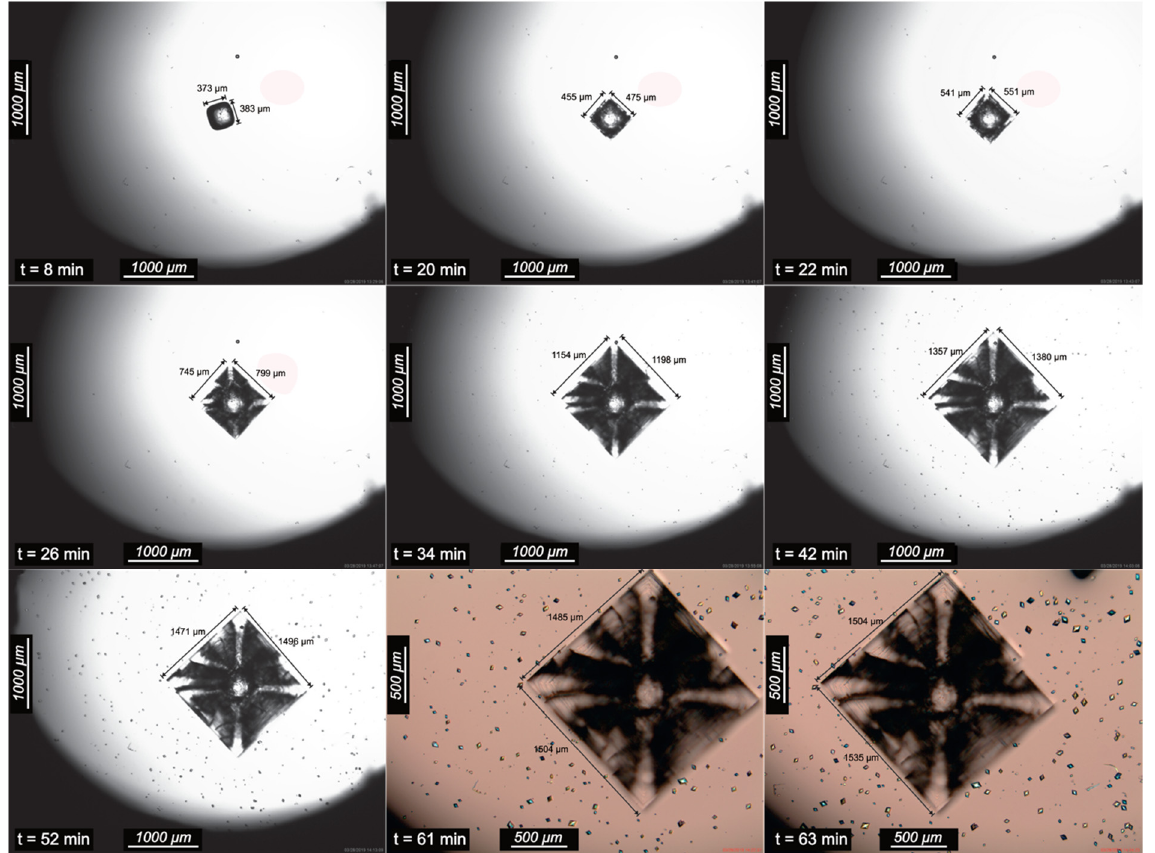
Figure 8. Optical photomicrographs along time of the NaCl–Na 2 SO 4 –H 2 O droplet under evaporation seeded with NaCl.